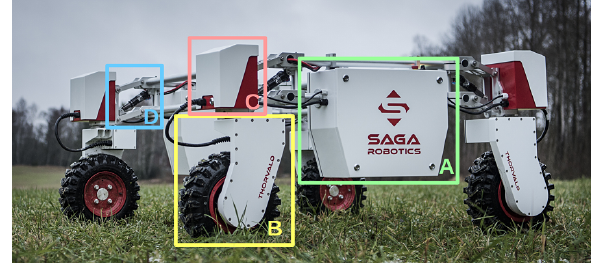
Figure 3: The most important robot modules. ( A ) bat- tery enclosure, ( B ) drive module, ( C ) steering module, ( D ) suspension